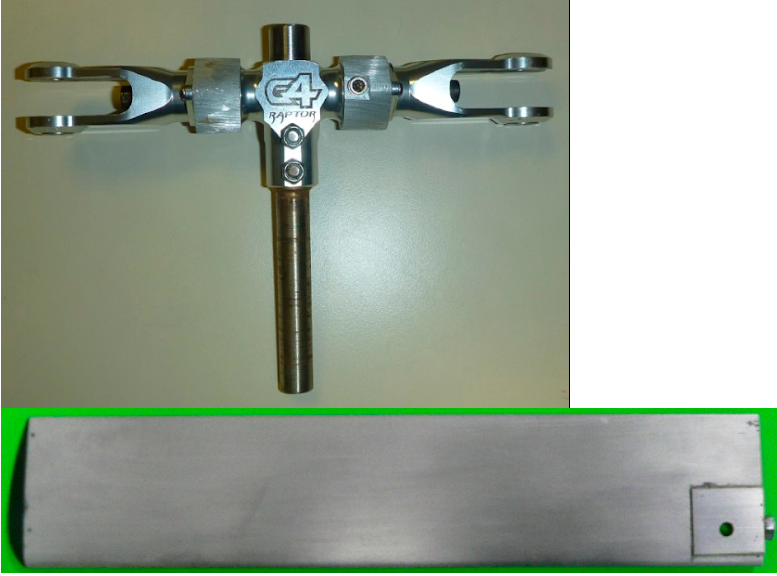
Figure 5. Rotor hub and blade.